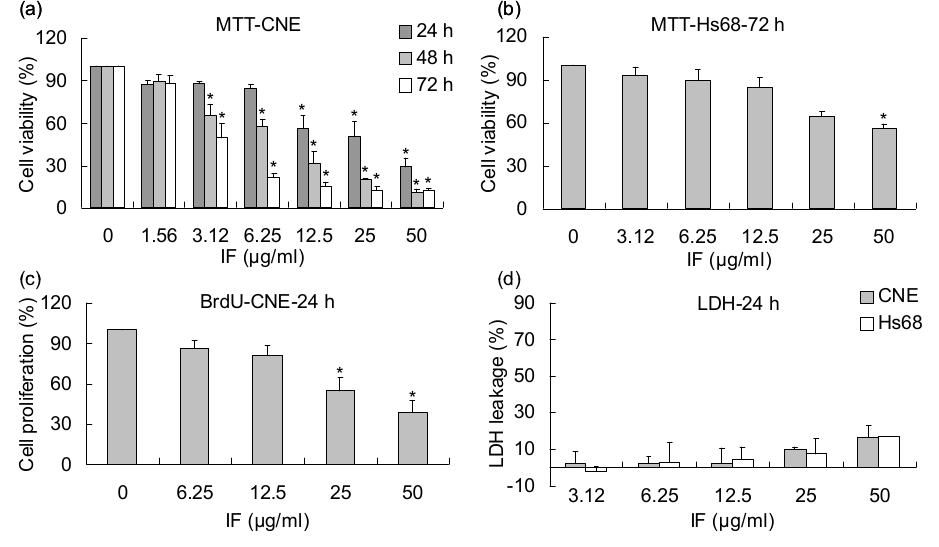
Figure 2. Effects of IF on the growth of CNE and Hs68 cells. (a) Effect of IF on the viability of CNE cells at 24-, 48-, 72-h treatments evaluated by MTT assay. (b) Effect of IF on the viability of Hs68 normal cells at 72-h treatment evaluated by MTT assay. (c) Effect of IF on the proliferation of CNE cells at 24-h treatment evaluated by BrdU assay. (d) Cytotoxic effects of IF on CNE and Hs68 cells at 24-h treatment evaluated by LDH assay. Each value represents the mean of three independent experiments. Difference between treatments and control with p < 0.05 (*) was considered statistically